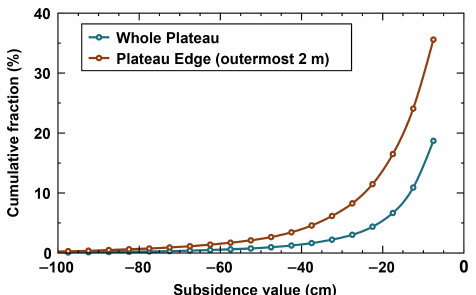
Figure 7. Subsidence distribution for the Šuoššjávri peat plateau. The edge is taken as the outermost 2m of the plateau. Only sub- sidence values greater than 0.05m are considered in this graph to guarantee a meaningful subsidence signal. Data are derived from the topography difference between 2015 and 2018. The percentages indicate which proportion of the total area (whole plateau or plateau edge) is affected by a subsidence higher than or equal to (in abso- lute value) a given subsidence value (e.g., 36% of the edge exhibits a subsidence higher than or equal to